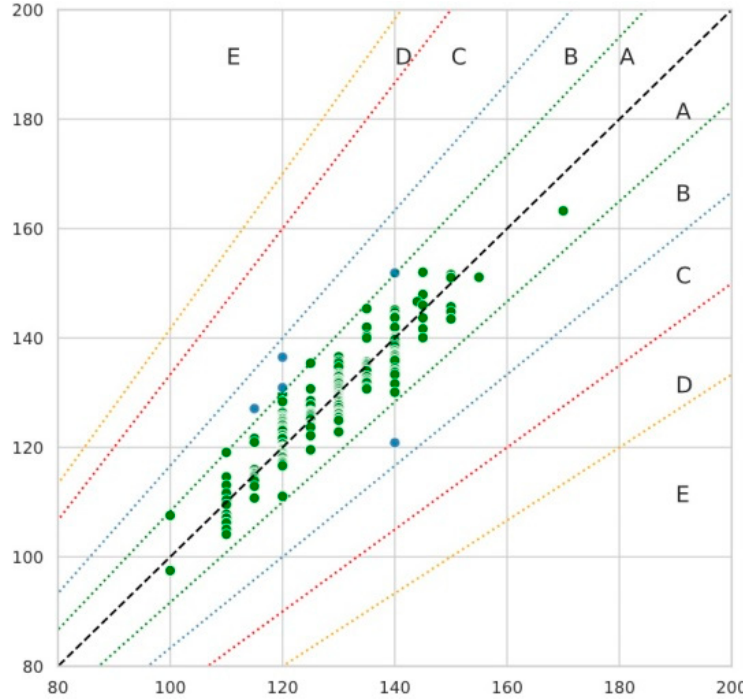
Figure 7. Zonal error grid analysis.